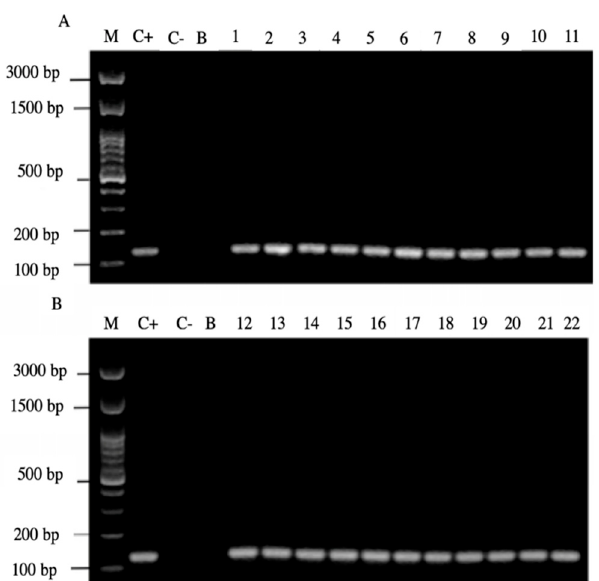
Figure 4. Agarose gel electrophoresis to detect the PCR amplification of the 16S rRNA gene of H. pylori (expected size 100 pb) from the DNA of yeast cells from vaginal discharges of term pregnant